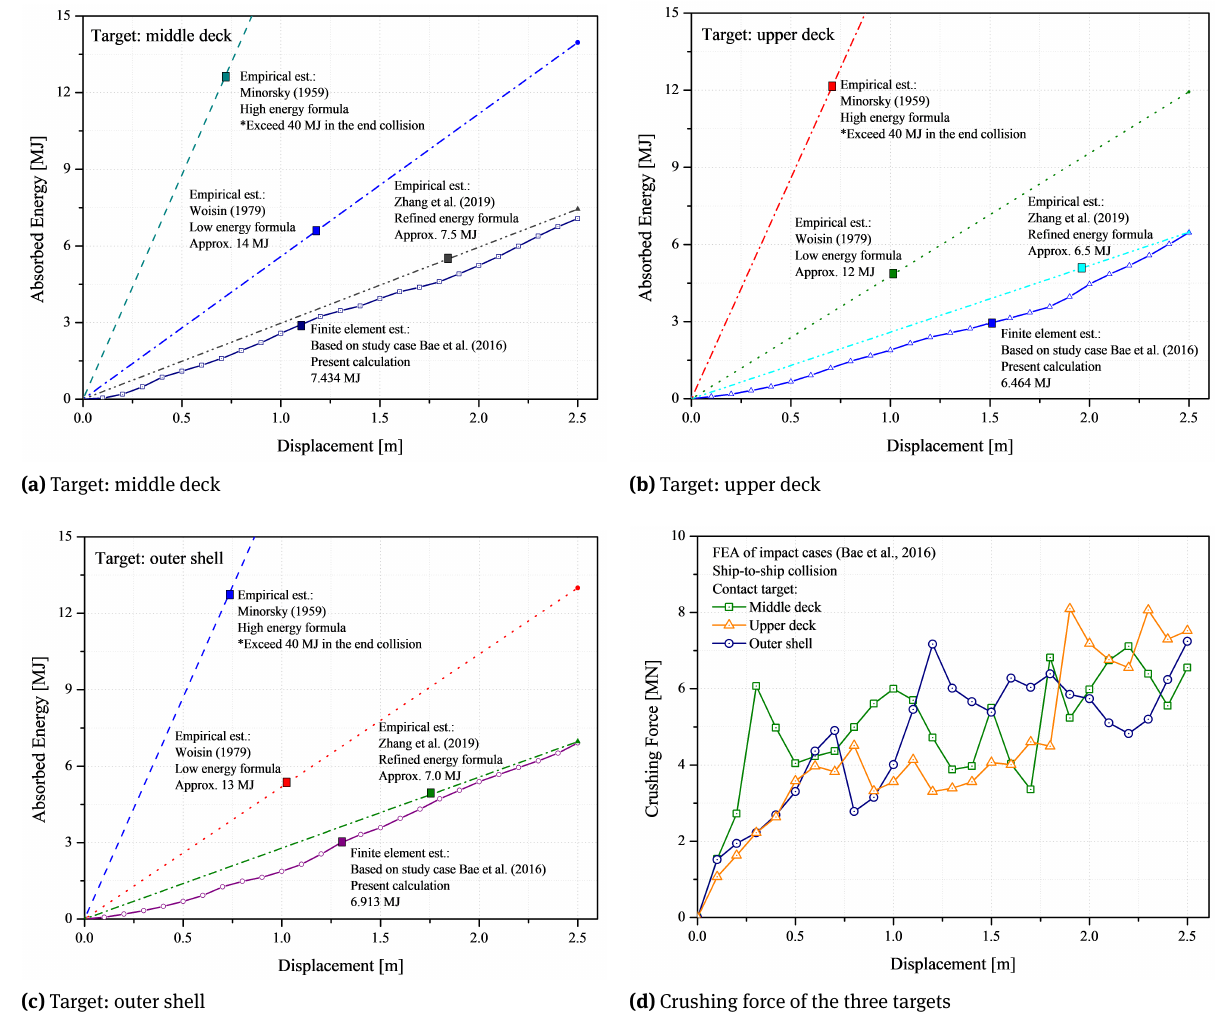
Figure 1: Comparison of the analyzed collision scenario by NLFEA and empirical